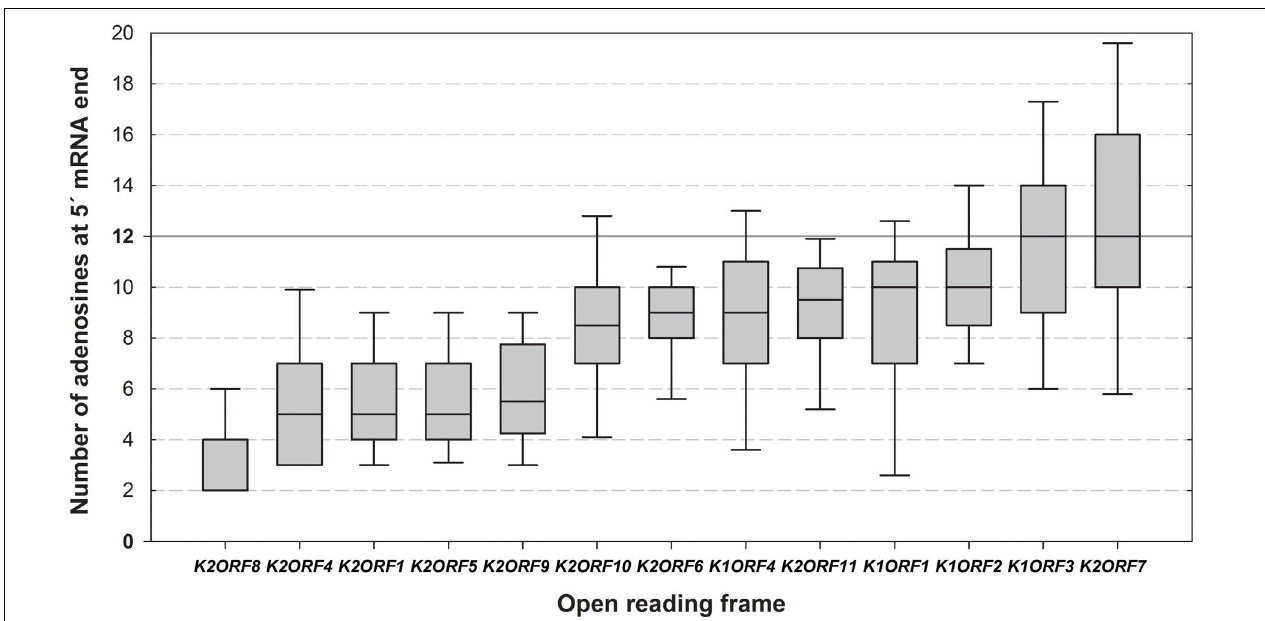
FIGURE 4 | Differences in the lengths of the 5 (cid:48) mRNA poly(A) leaders of individual pGKL ORFs. The box whisker plot represents the number of templated and non-templated consecutive adenosine nucleotides at the 5 (cid:48) ends of pGKL mRNAs. The bottom and top of the box indicate the first and third quartiles, respectively. The whiskers indicate the 10th and 90th percentiles. The median is indicated as a solid black line. Outliers are not indicated. The open reading frames are ranked from left to right according to the prevalent lengths of the 5 (cid:48) poly(A) leaders of their mRNAs. The value of 12 adenosine nucleotides represents an optimal length of the Pab1 binding site and is indicated as a solid gray line. The pGKL1 mRNAs belong to those with the longest 5 (cid:48) poly(A) leaders. The data did not follow a normal distribution according to the Shapiro–Wilk test. The results were statistically analyzed using the non-parametric Kruskal–Wallis test, which supported rejection of the null hypothesis, p -value = 2.172940e-48. To discern gene pairs, the transcripts of which significantly differed in the lengths of their 5 (cid:48) poly(A) leaders, we performed Dunn post hoc tests followed by adjustment of p -values according to the Benjamini–Hochberg FDR method. Adjusted p -values corresponding to all possible gene pairs are depicted in Supplementary Table S10 . In total, 458 sequences obtained by 5 (cid:48) RACE-PCR were used for this analysis ( Supplementary Table S5A